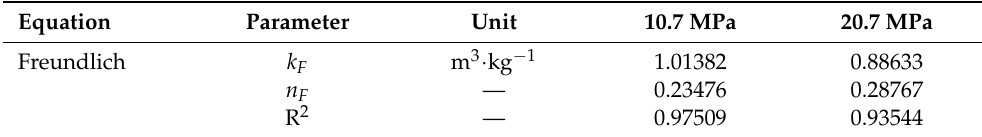
Figure A4. Uptake of Pt(cod)me 2 on RFA at 308 K and different pressures; experimental data taken from [10]. Table A4. Adsorption isotherm parameters for Pt(cod)me 2 from scCO 2 solution on RFA at 308 K and different pressures [10].